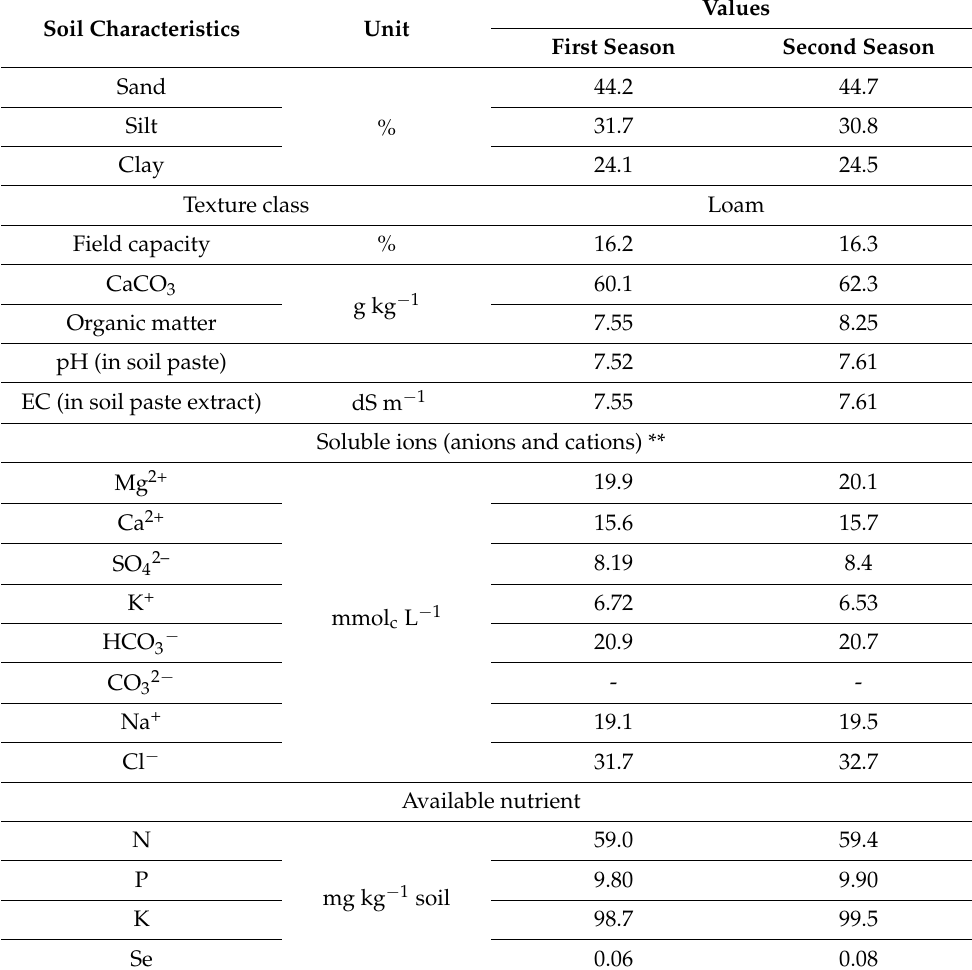
Table 1. Some major properties of the investigated